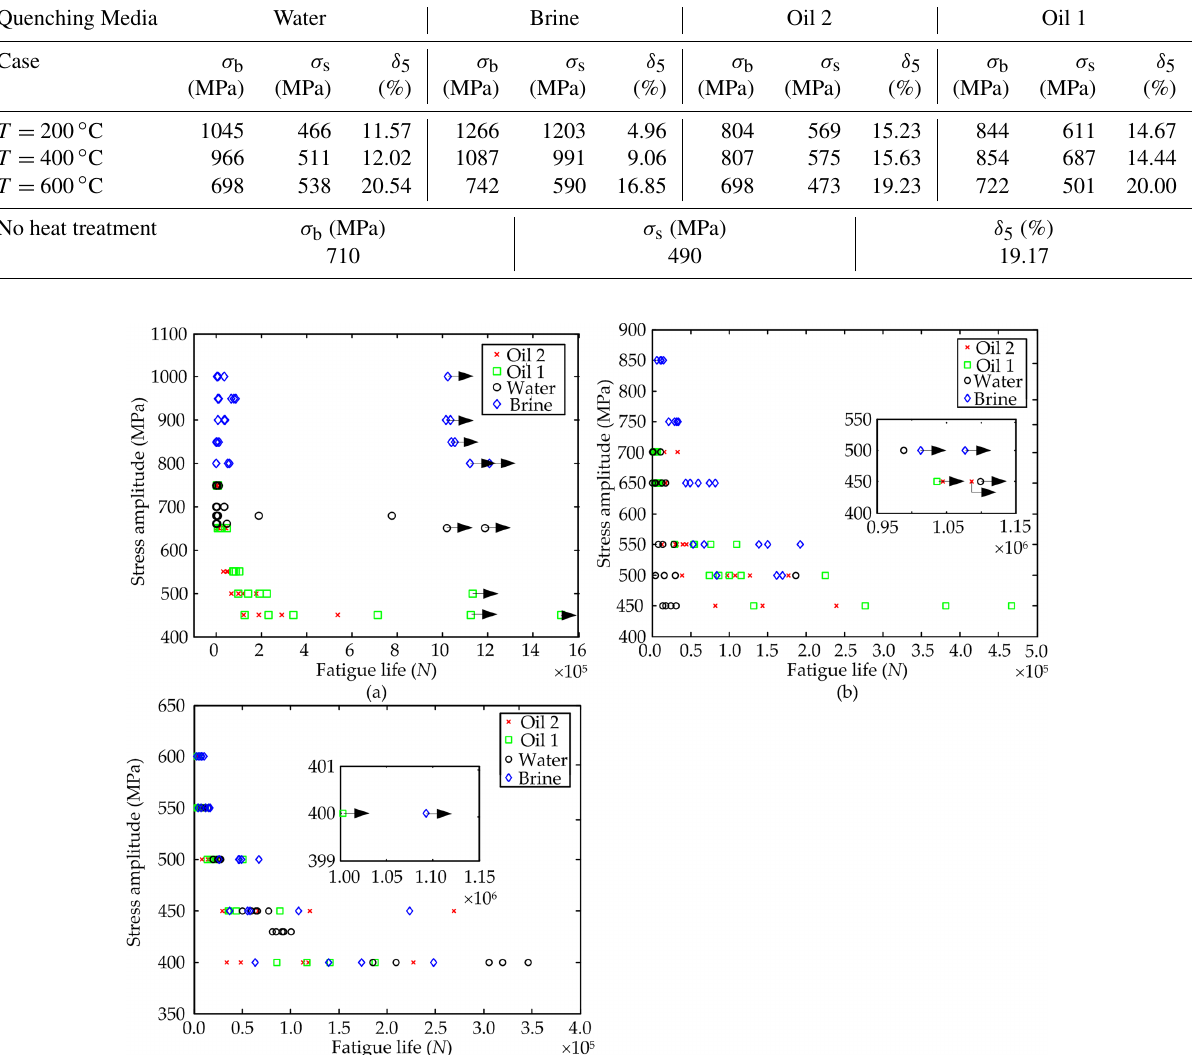
Figure 3. Scatter plot of the fatigue tests with tempering temperature (a) 200 ◦ C, (b) 400 ◦ C and (c) 600 ◦